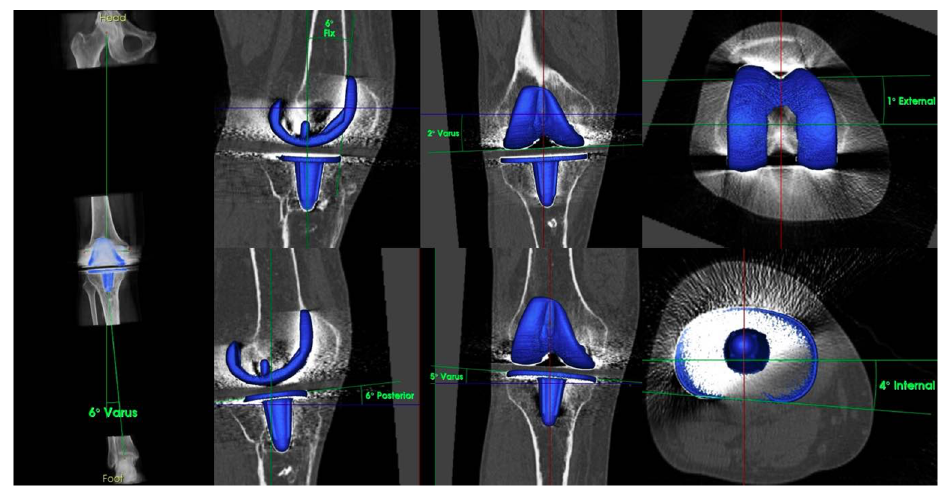
Figure 4. TKA component position in 3D reconstructed CT scans.